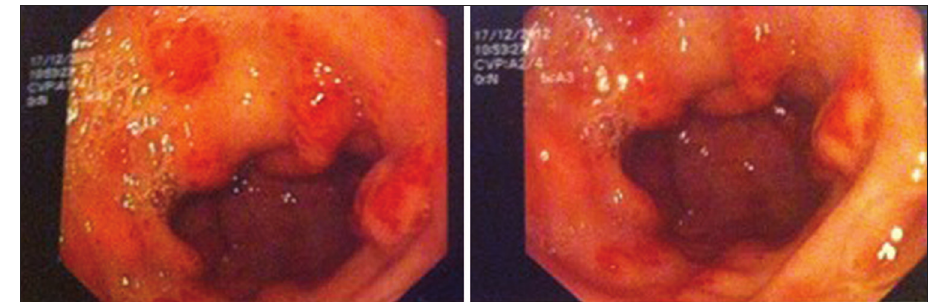
Figure 1. Endoscopic image of GAVE. Typical endoscopic appearance of “watermelon” stomach after the first